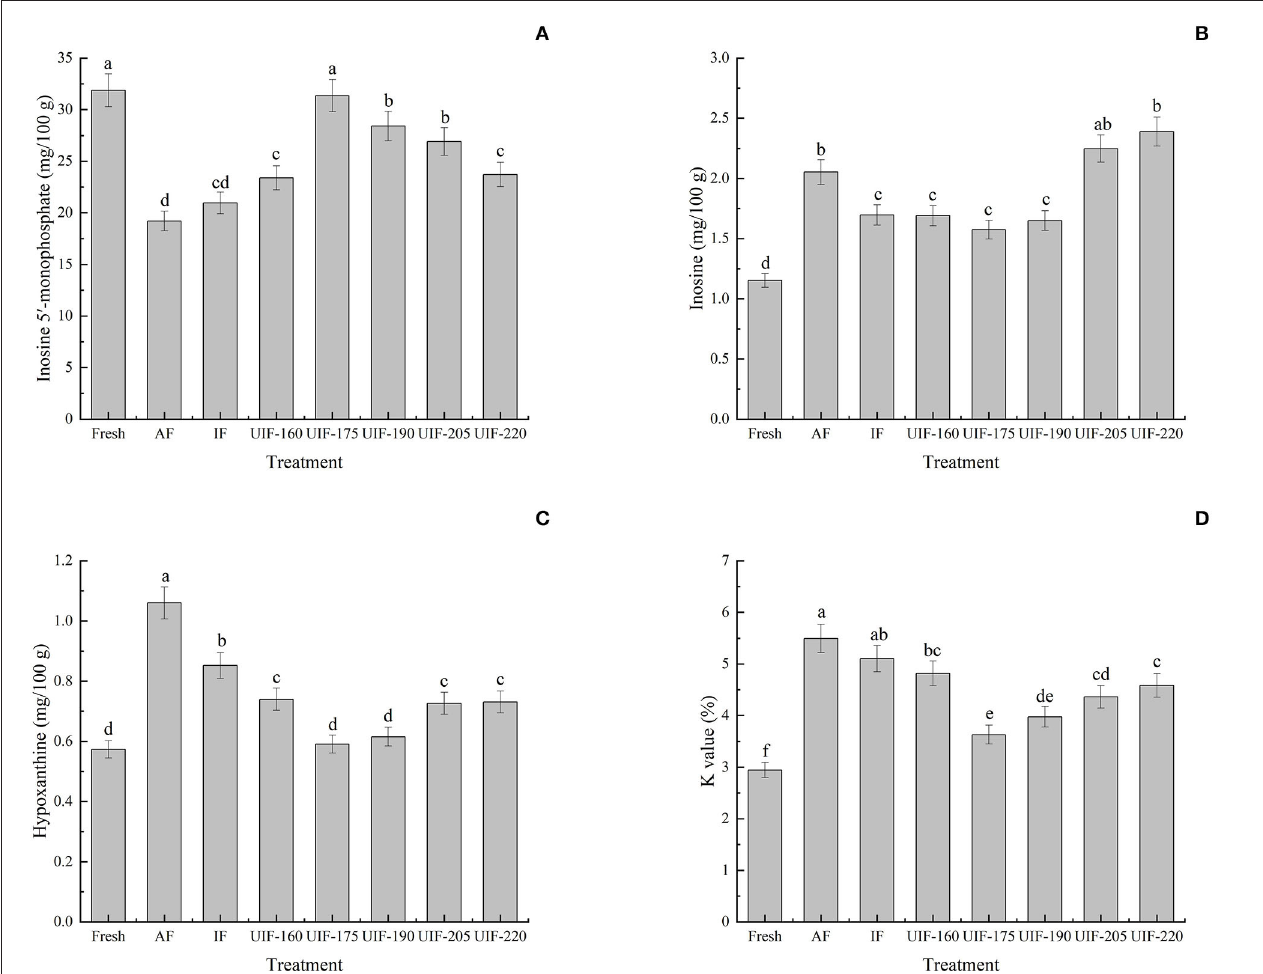
FIGURE 7 | Influence of different freezing treatments on the inosine 5 ′ -monophosphate (IMP) (A) , inosine (HxR) (B) , hypoxanthine (Hx) (C) , and K values (D) of the large yellow croaker. The results are average ± standard deviation ( n = 3).